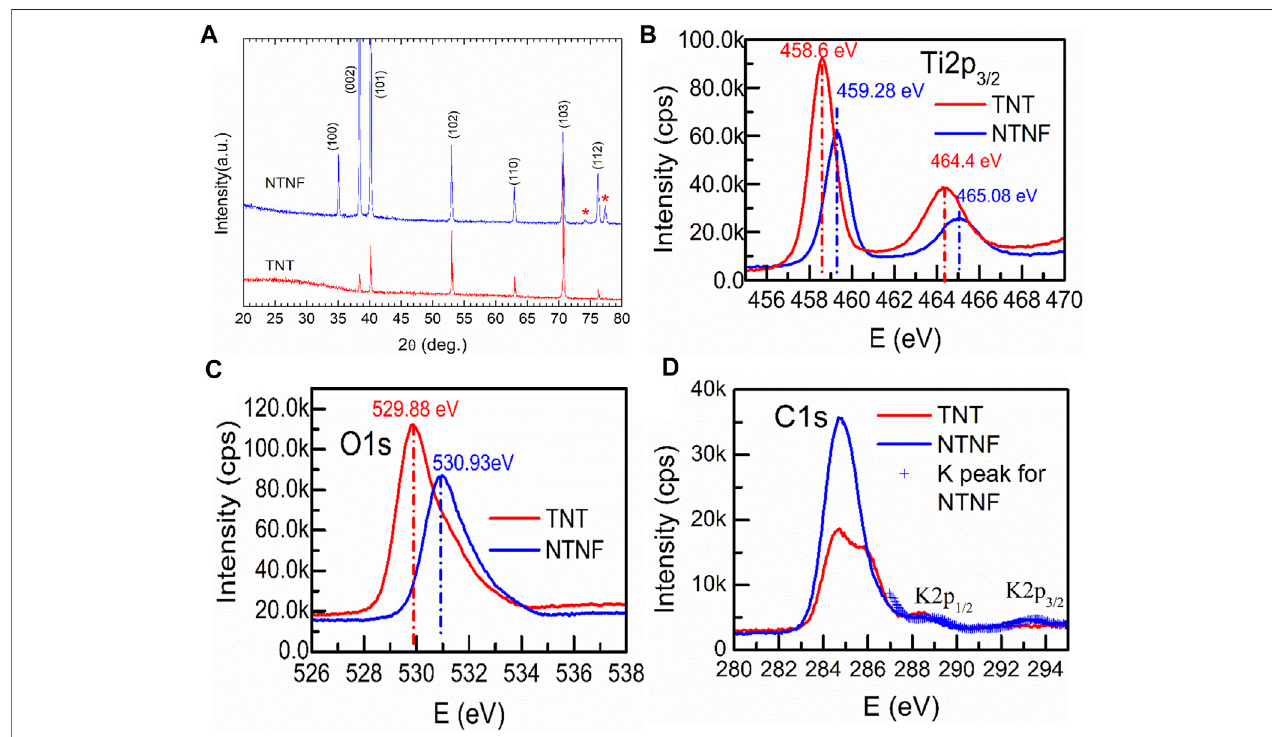
FIGURE 4 | (A) XRD patterns of the TNT and NTNF. The XPS patterns around Ti 2 p (B) , O 1 s (C) , C 1 s , and K 2 p (D) peaks for the TNT and NTNF samples.